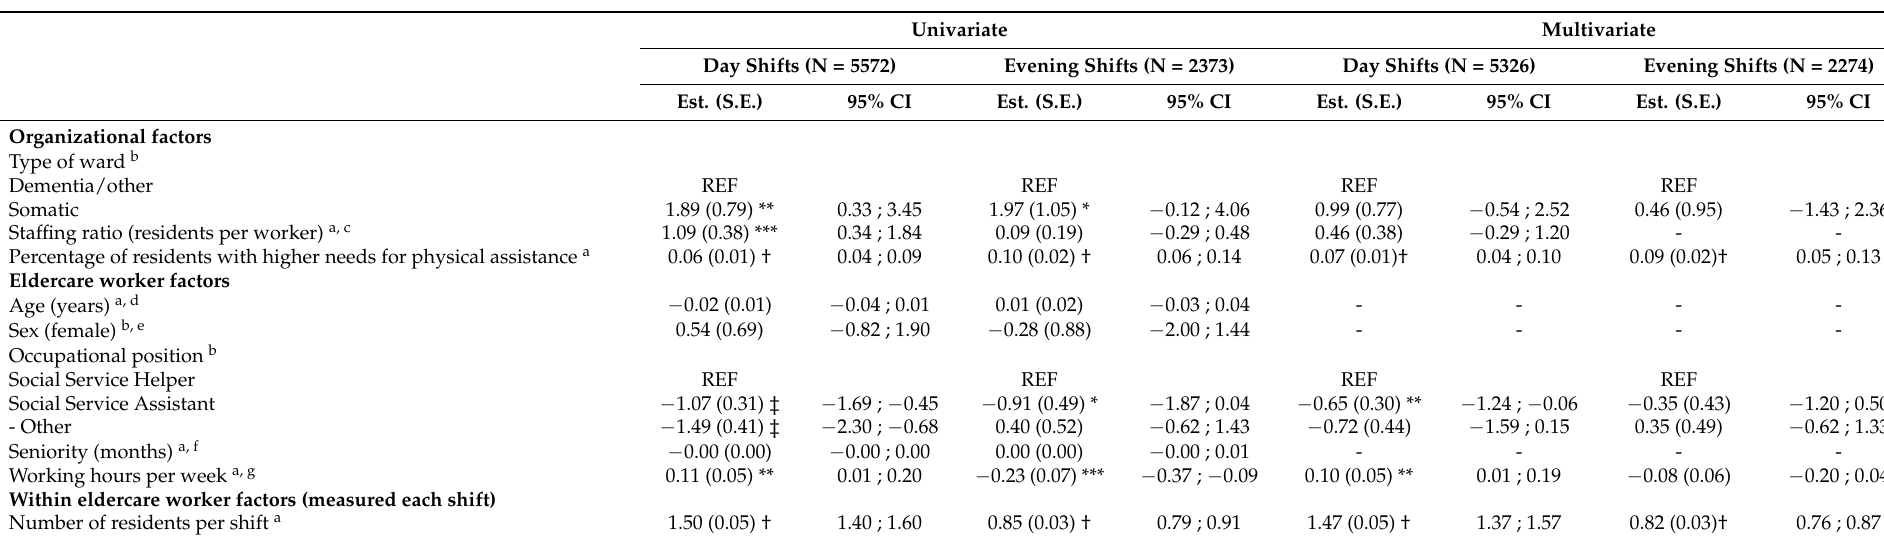
Table 4. Univariate and multivariate analysis of the association between organizational, eldercare worker factors, within eldercare worker factors and the number of resident handlings performed per shift stratified on day and evening shift work. (Est. = Estimate; S.E. = Standard Error; 95% CI = 95% confidence